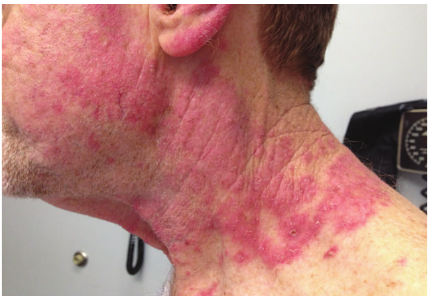
Figure 2: Figure showing spread of erythematous, pruritic rash on neck.